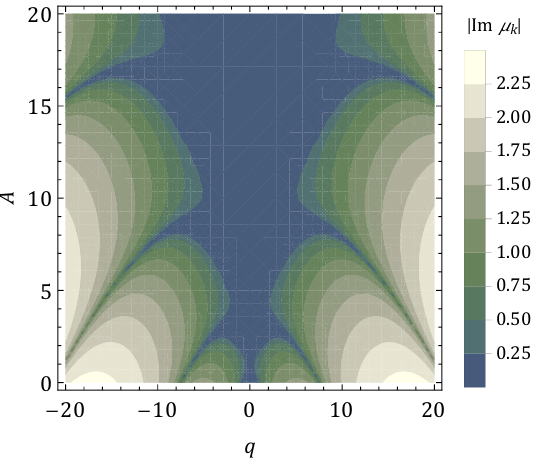
Figure 2 . Floquet chart for eq. (2.3). The lighter regions correspond to unstable bands while the darker blue regions are stable with Im µ k ( A k , q ) = 0